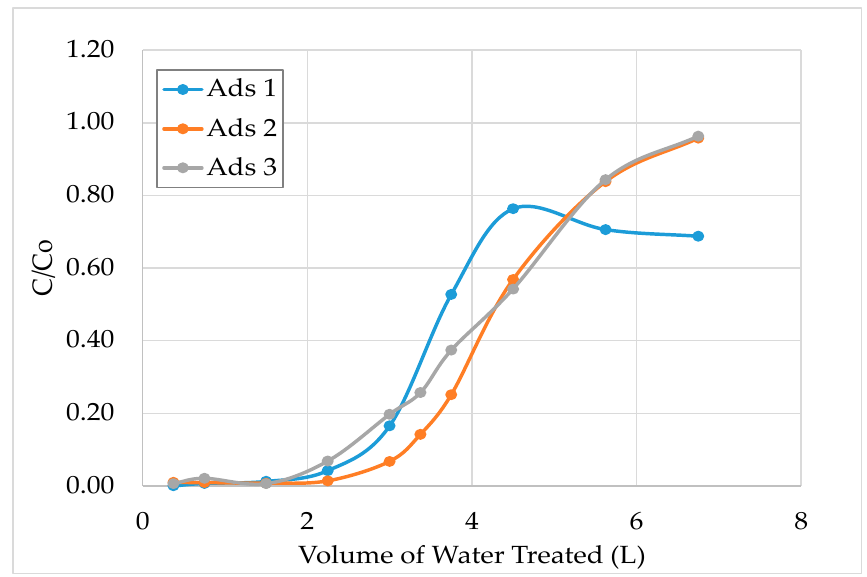
Figure 5. Breakthrough curves of the three adsorption experiments for sulphate ion.